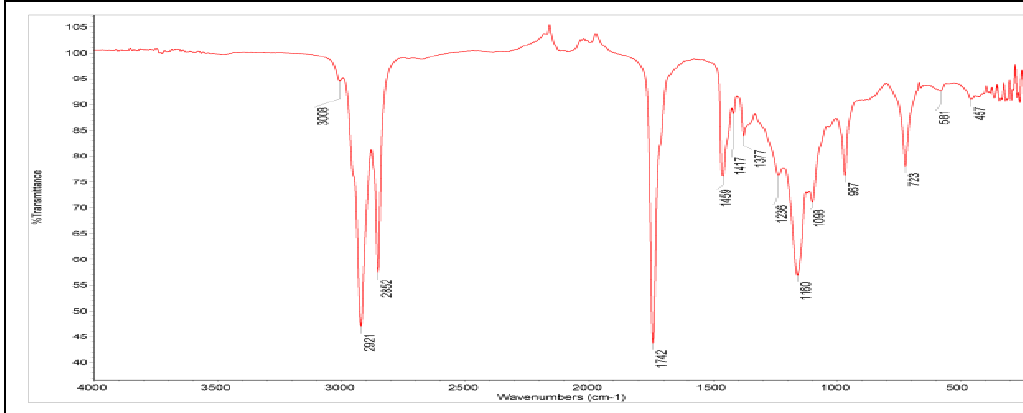
Figure 14. FTIR spectrum of safflower oil. (27) Powder X-ray diffraction (PXRD) XRD test of the pure drug and the selected formula (F16) was done to detect the polymorphic structure of the drug before and after formulation. Generally, the amorphous mater sate has higher physical stability. Crystalline nature of pure ITZ easily detected